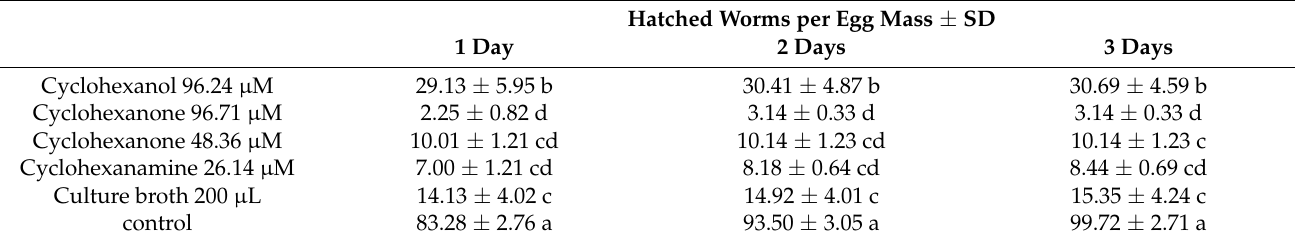
Table 1. Effects of three VOCs and culture broth on egg hatching of M. incognita . Hatched Worms per Egg Mass ±